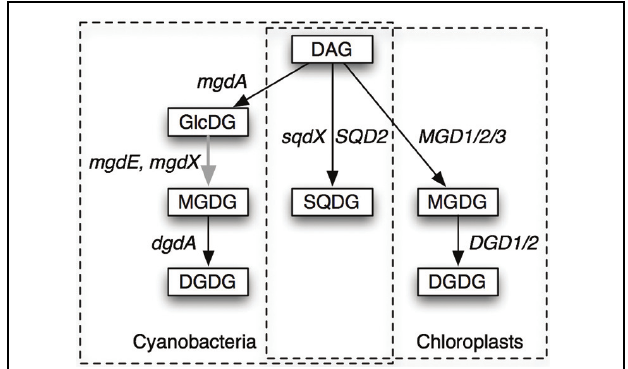
FIGURE 1 | Pathways of synthesis of glycolipids in cyanobacteria and chloroplasts. The pathways and the genes involved in the processes are shown. DAG, diacylglycerol; GlcDG, monoglucosyl diacylglycerol; MGDG, monogalactosyl diacylglycerol; DGDG, digalactosyl diacylglycerol; SQDG, sulfoquinovosyl diacylglycerol. Gene names are explained in the text. mgdX is a hypothetical alternative gene encoding the epimerase. Solid arrows indicate glycosyltransferases (GT), while the gray arrow indicates an epimerase.